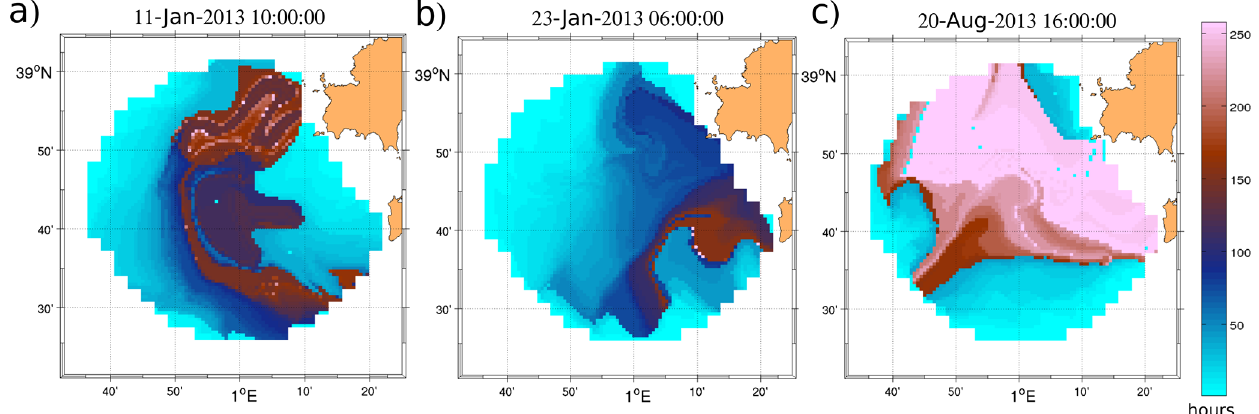
Figure 11. Maps of particle residence times (hours) computed for different dates and seasons from HFR observations in the Ibiza Channel SOCIB ( a, b for winter and c for summer conditions). Original source: from Rubio et al.